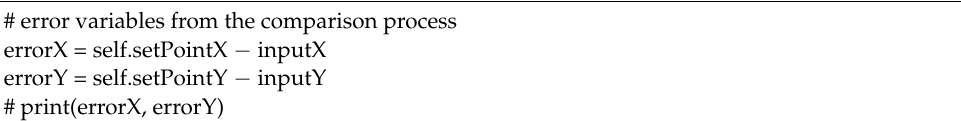
Algorithm 6. Fragment of the Python code: calculation of the error values.